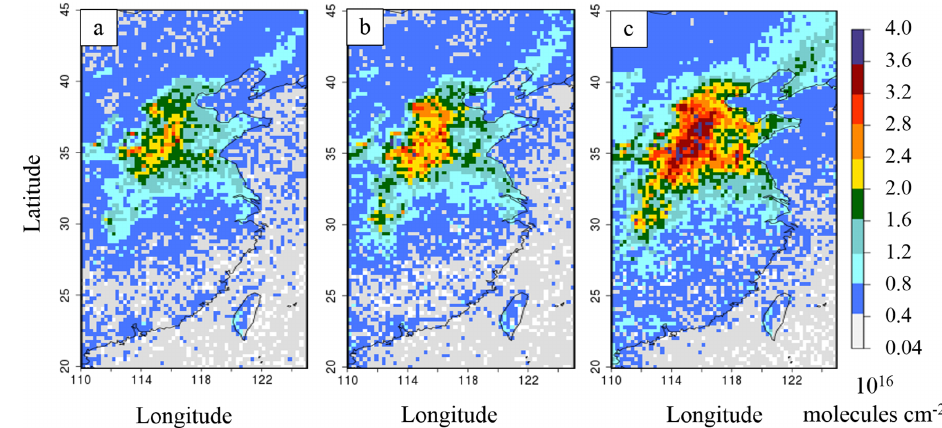
Figure 1. IASI instrument NH 3 ( g ) total columns over eastern China (110–125 ◦ E, 20–45 ◦ N), in 10 16 moleculescm − 2 for (a) 2011, (b) 2013 and (c) 2015. In this figure, the available observations have been averaged on a 0.25 ◦ × 0.25 ◦